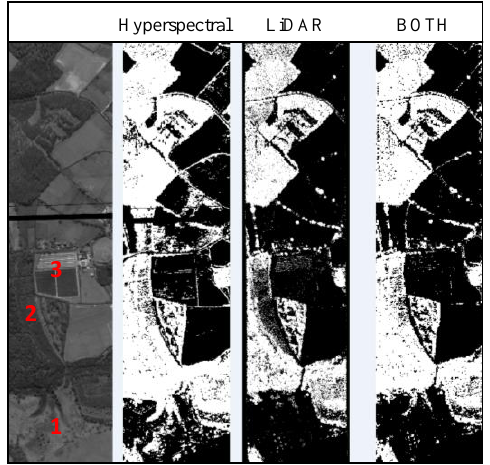
Figure 13. Tree coverage maps of each test